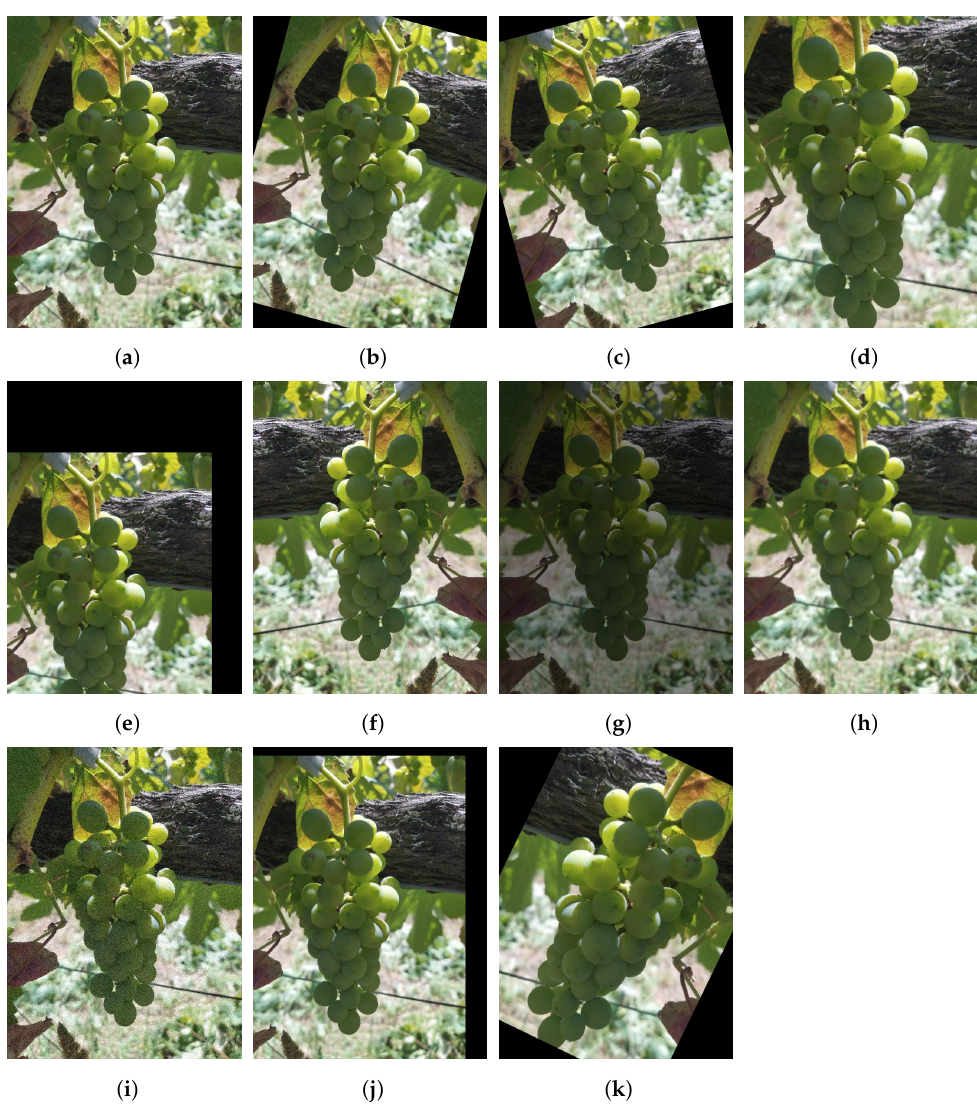
Figure 3. Augmentation operations applied to a dataset image. ( a ) Original. ( b ) Rotation +15 ◦ . ( c ) Rotation − 15 ◦ . ( d ) Scale. ( e ) Translation. ( f ) Flip. ( g ) Multiply. ( h ) Blur. ( i ) Noise. ( j ) Combination 1. ( k ) Combination